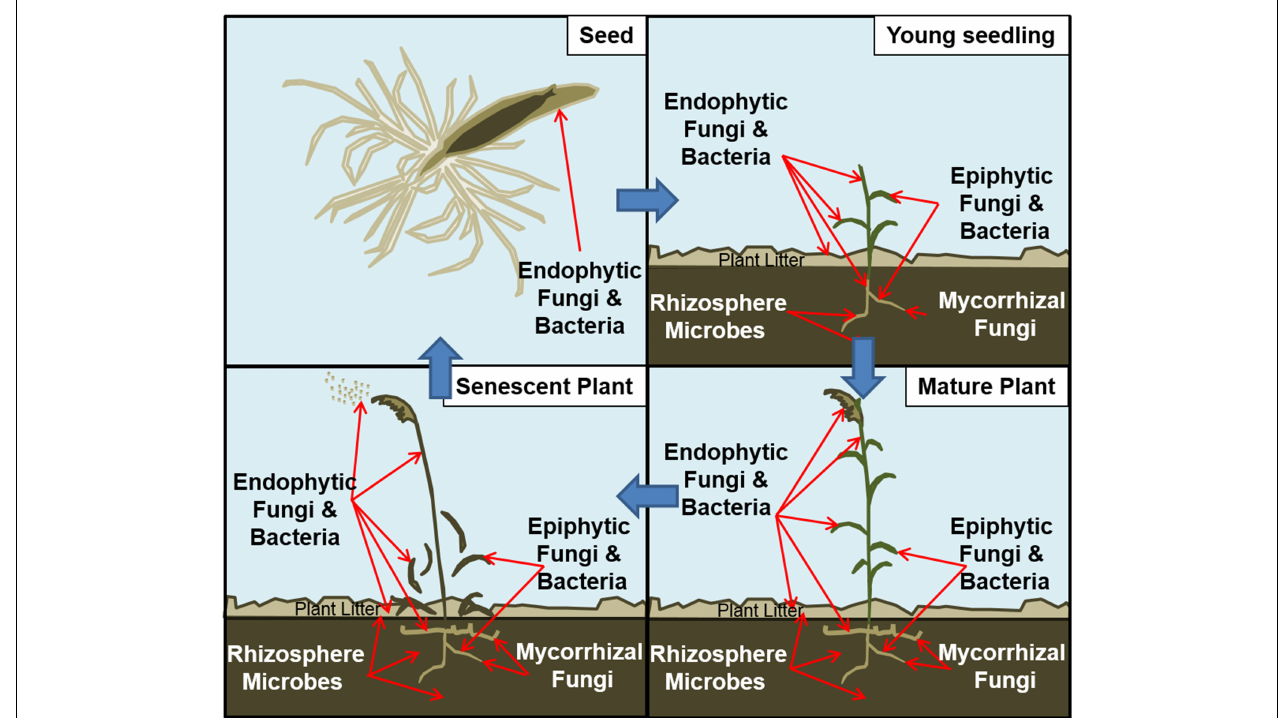
FIGURE 1 | Schematic of microbiome surrounding a plant throughout its life history. UL: Endophytic fungi and bacteria can be transmitted within the seed coats of certain plant species. UR: As seeds germinate, roots, stems, and leaves of seedlings can be inhabited by various microbes. Those microbes may have been transmitted through seeds, soil